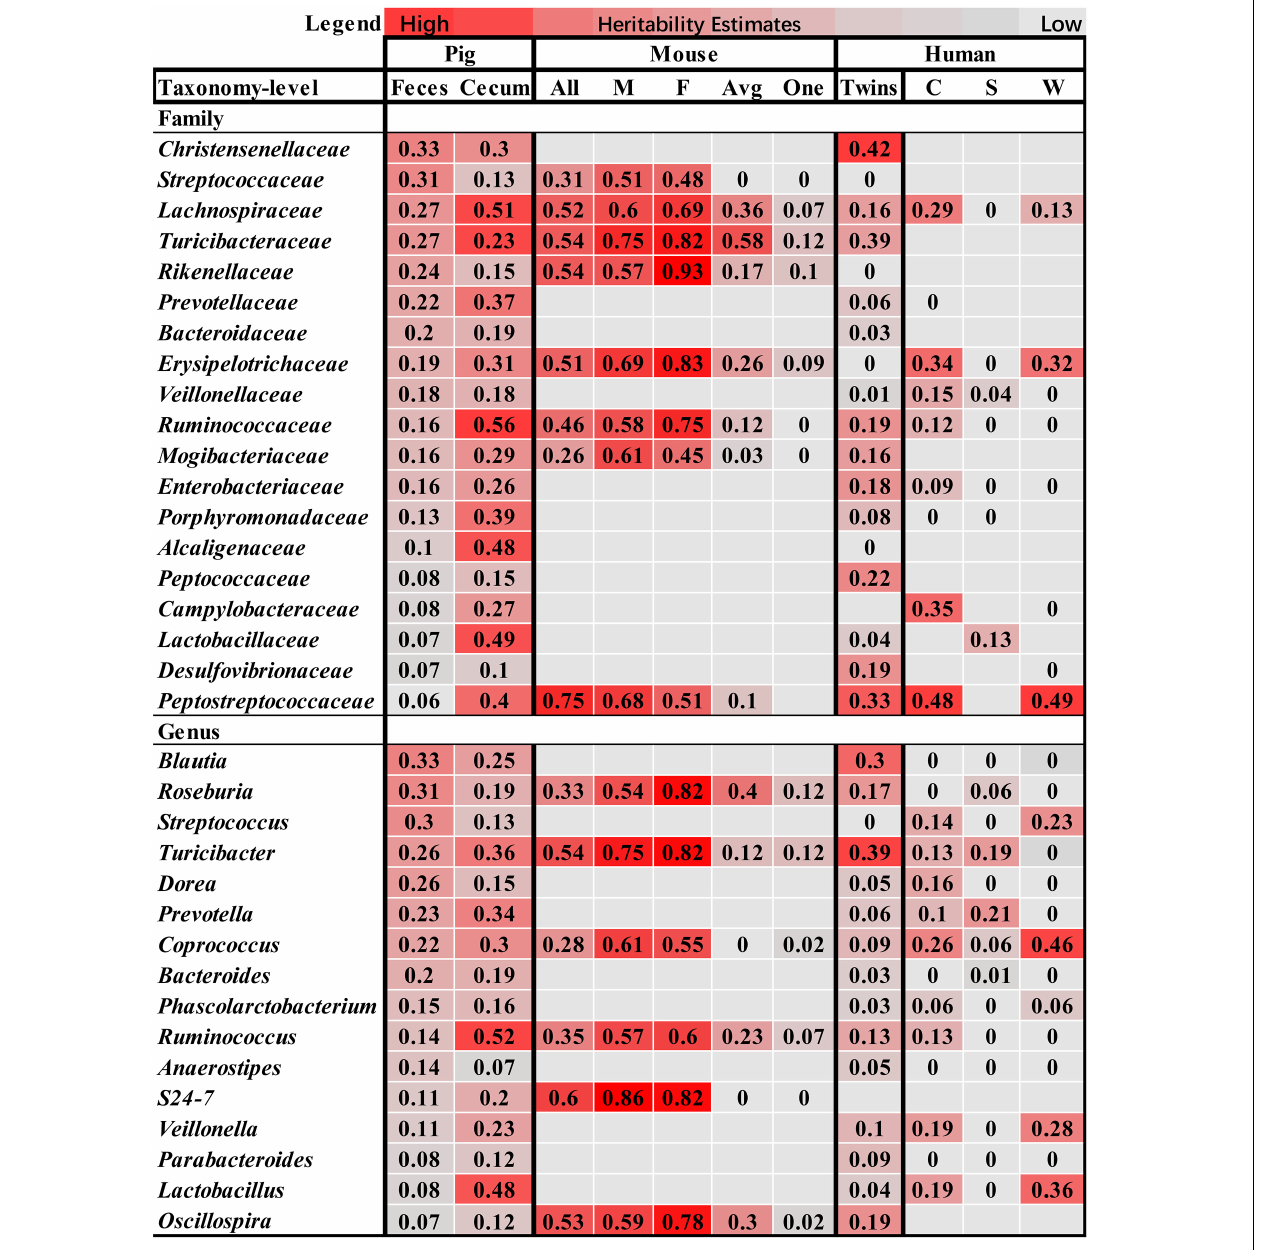
FIGURE 5 | Comparison of the heritability of microbial taxa among pig, human and mouse. The color gradient over the heritability estimates ranges from the lowest heritability estimate (white) to the highest heritability estimate (red) in the given study. The heritability estimates in mouse were obtained from the studies reported by Org et al. (2015b), in which heritability was estimated using all mice (All), male (M), female (F), an average per strain (Avg) and a single mouse per strain (One), and O’Connor et al. (2014). The estimates in human were referred to the studies by Goodrich et al. (2016a), and Davenport et al. (2015), in which the heritability was estimated in the Winter (W), Summer (S), and seasons combined dataset